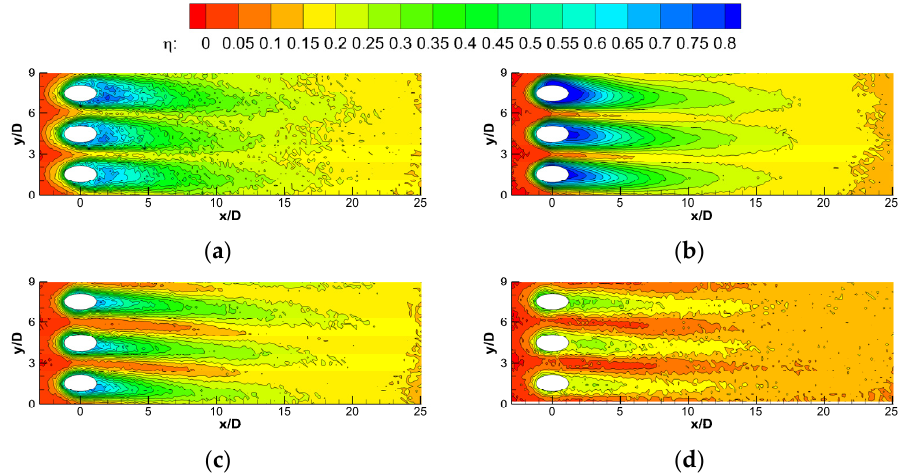
Figure 9. Distribution of film effectiveness at different blockage ratios, M = 1.05. ( a ) B = 0; ( b ) B = 0.2; ( c ) B = 0.5; ( d ) B = 0.8.